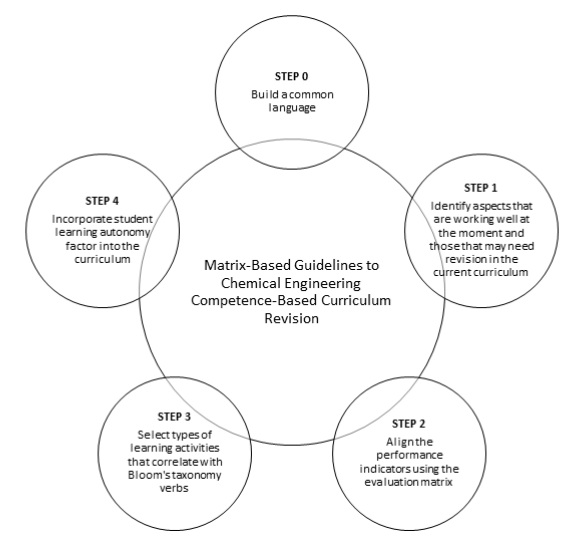
Fig. 2. Description of the steps in the curricular